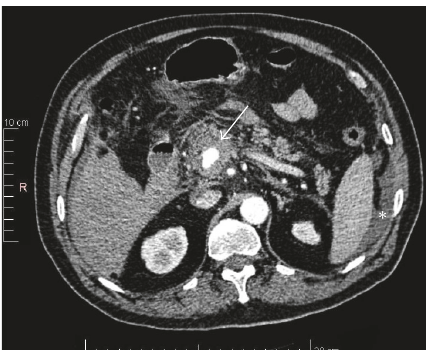
Figure 1: Contrast-enhanced CT scan of the abdomen prior to transarterial embolization : A 2.0- × 1.4cm visceral aneurysm (Arrow) surrounded by 0.7 cm rim of thrombus arising from the inferior pancreaticoduodenal branch. The hemoperitoneum is also noticed in this figure (Asterisk) .